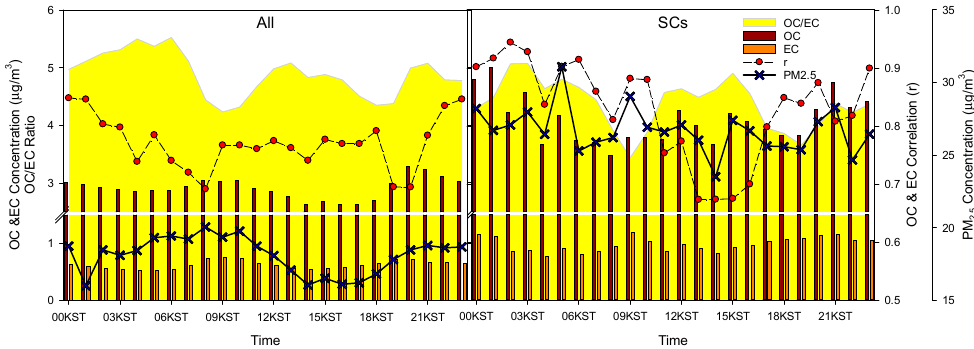
Figure 11. Diurnal changes in the ratio of OC to EC, the concentrations of OC and EC, and the correlation between OC and EC ( left : ALL, right : SCs).